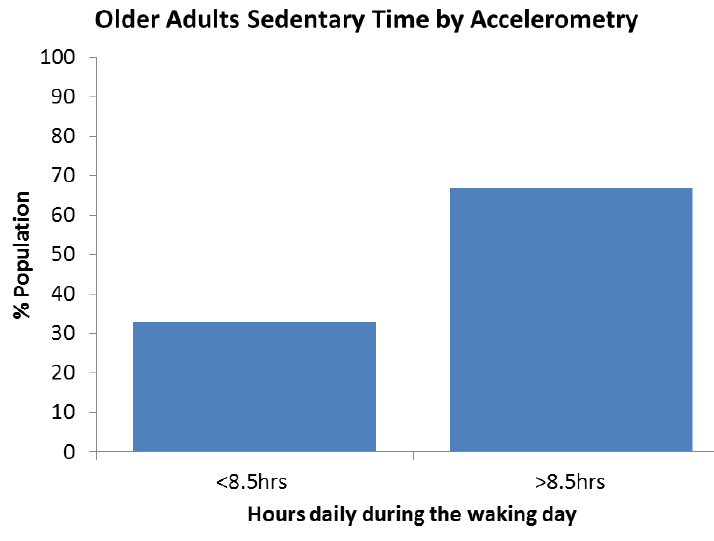
Figure 7. Prevalence of sedentary behavior by accelerometry in 649 older